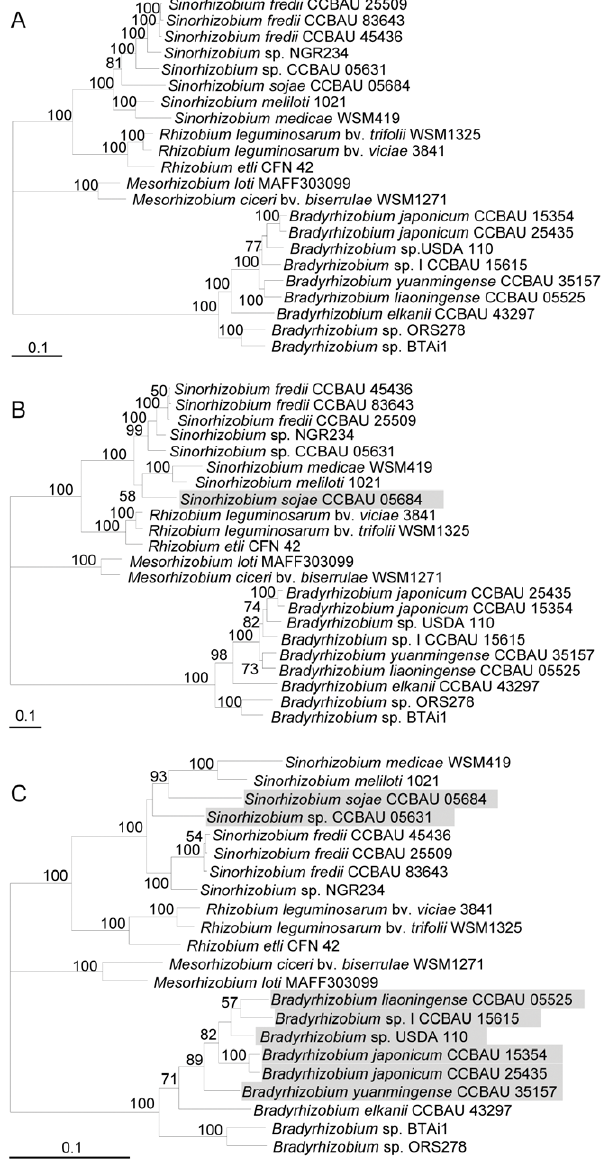
(Table S10), 320/325 interspecies ANIstt values were below 94%, R. yanglingense , R. loessense and R. gallicum may belong to the same species due to their high ANIstt values (96.43%–97.79%), R. indigoferae and R. leguminosarum had ANIstt of 98.71%, ANIstt